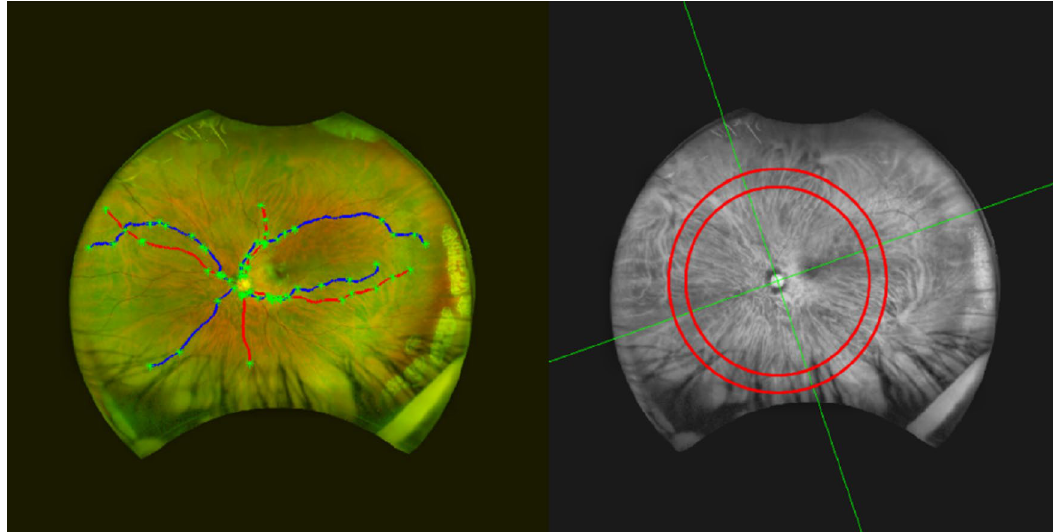
Figure 1. UWF imaging and analysis . Left: Example of the 8 vessels selected for analysis in a participant (2 from each quadrant). Veins are blue and arteries red, with the nodes (i.e., crossings, bifurcations, start and end points) plotted as green crosses. Right: The red channel of the same image separated into quadrants (green lines), with 6.5 to 8.5 optic disc radii marked with the red concentric circles.